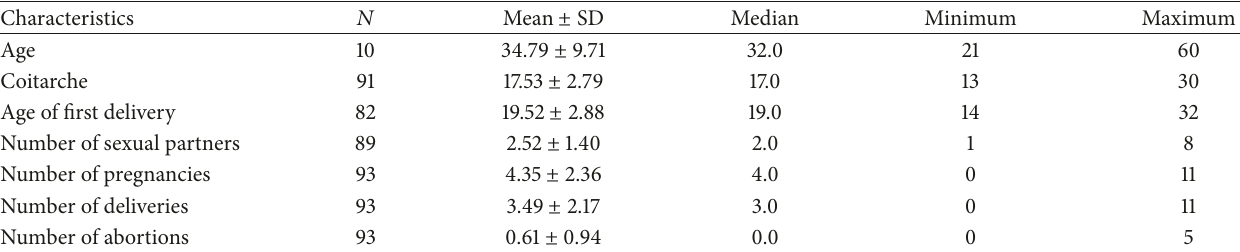
Table 1: Epidemiology of 100 subjects undergoing first Pap smear in Pr´ıncipe Island.